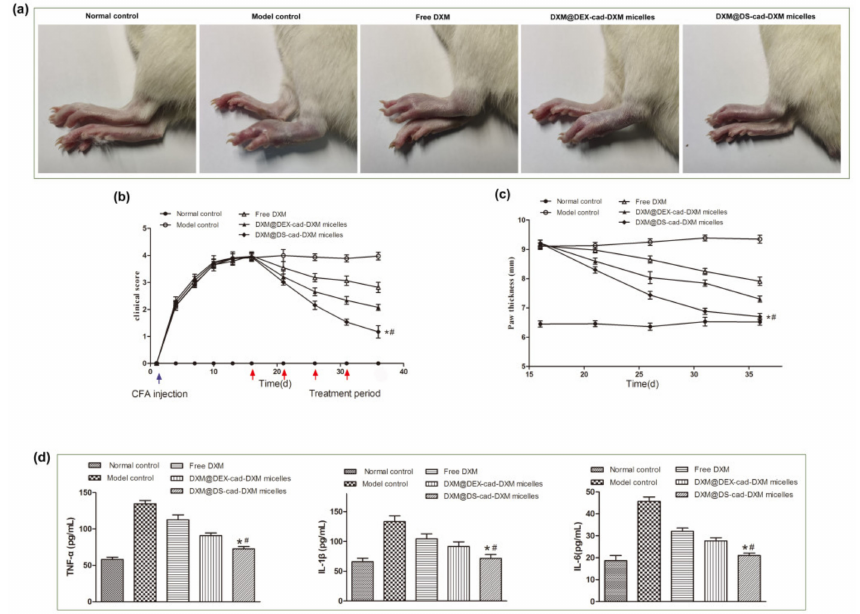
Figure 7. Photographs of the hind paw from AIA rats after administration of different formulations ( a ). The clinical score ( b ) and paw thickness ( c ) during the treatment. The levels of pro-inflammatory cytokines in the joint tissue after the treatment ( d ). Data are presented as the mean ± SD (n = 3, * p < 0.05, # p <